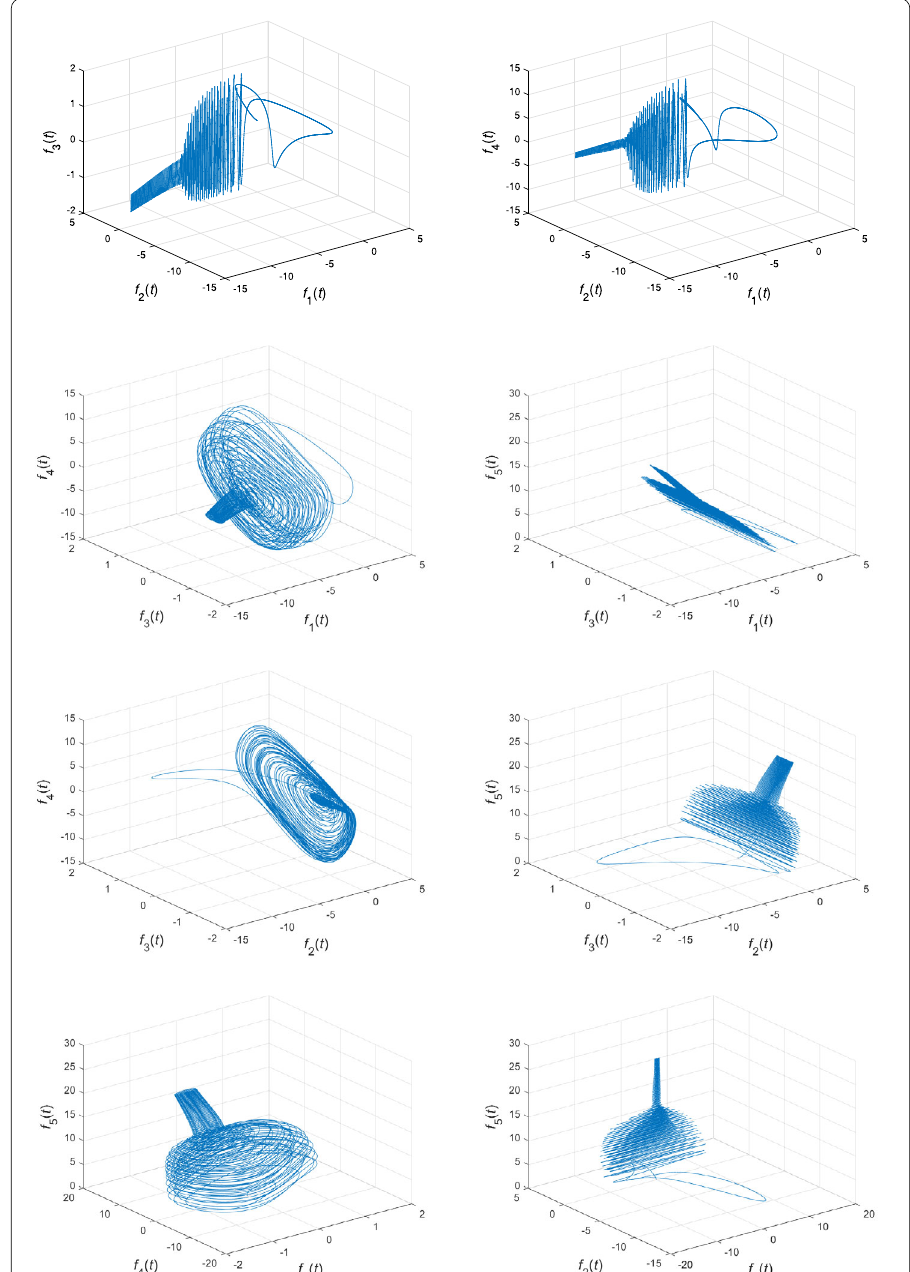
Figure 4 Three-dimensional phase planes of the fractional cardiac conduction model (10) for q i =